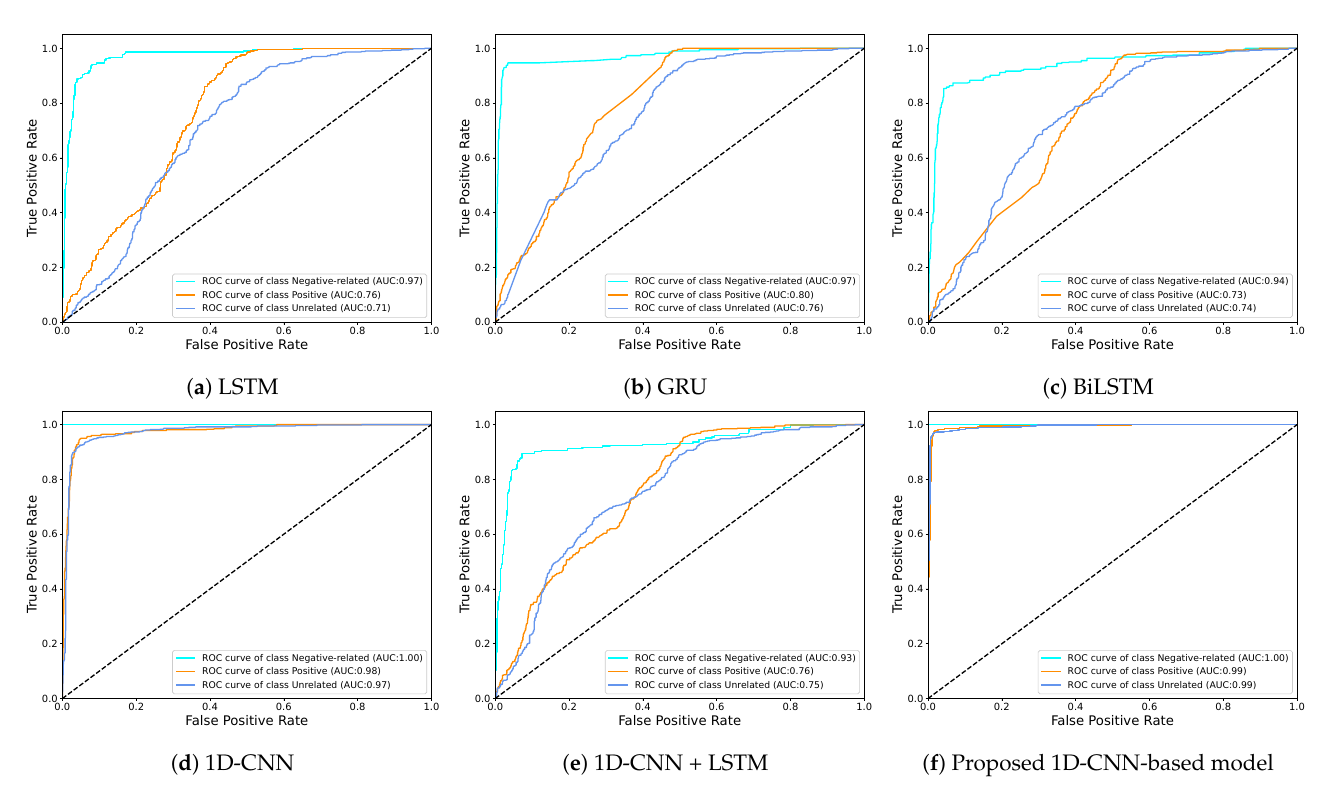
( f ) Proposed 1D-CNN-based model Figure 9. ROC curve comparison for ( a ) LSTM, ( b ) GRU, ( c ) BiLSTM, ( d ) 1D-CNN, ( e ) 1D- CNN+LSTM, and ( f ) the proposed 1D-CNN-based